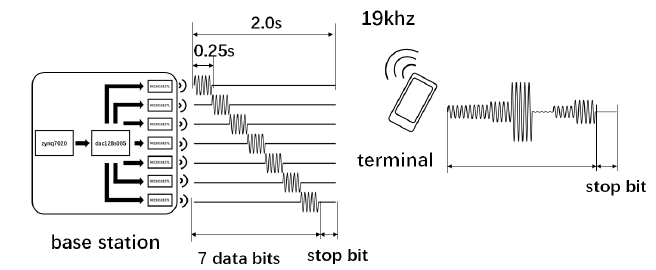
Figure 4. Audio signal transmission and